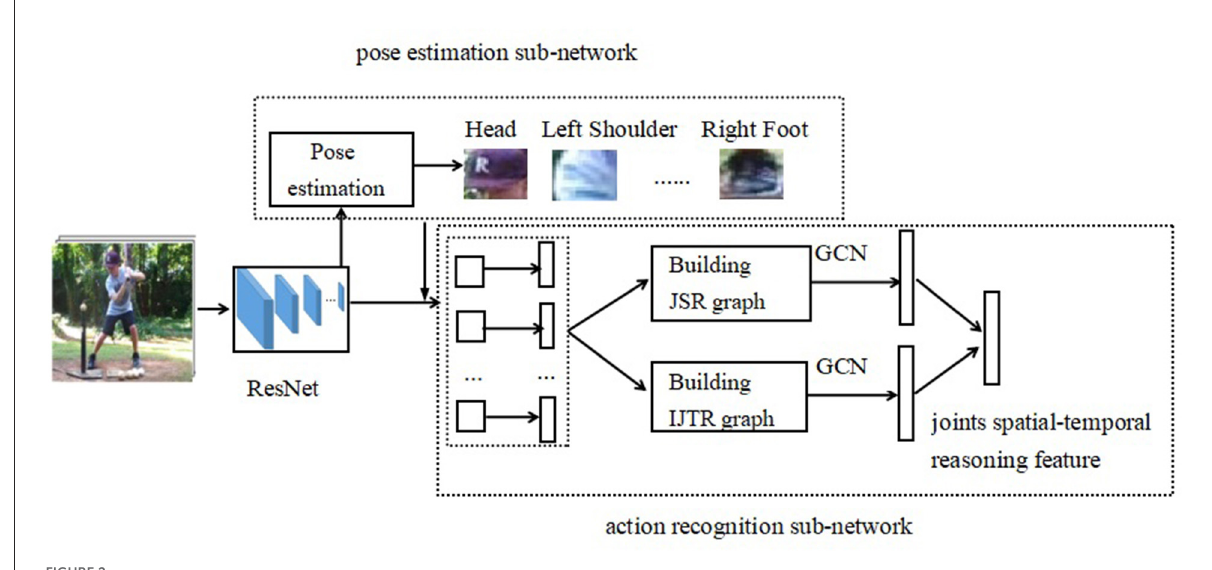
FIGURE2 The framework of JSTR. The video frames are fed into a backbone network, such as Resnet. The last convolution layer feeds into a pose estimation sub-network and generates the position of body joints. The features of each joint are extracted by RoIAlign according to the positions of body joints. Upon these original features and positions of joints, a spatial-temporal reasoning graph is built. Then, the spatial features and temporal features are fused to recognize the action from videos.